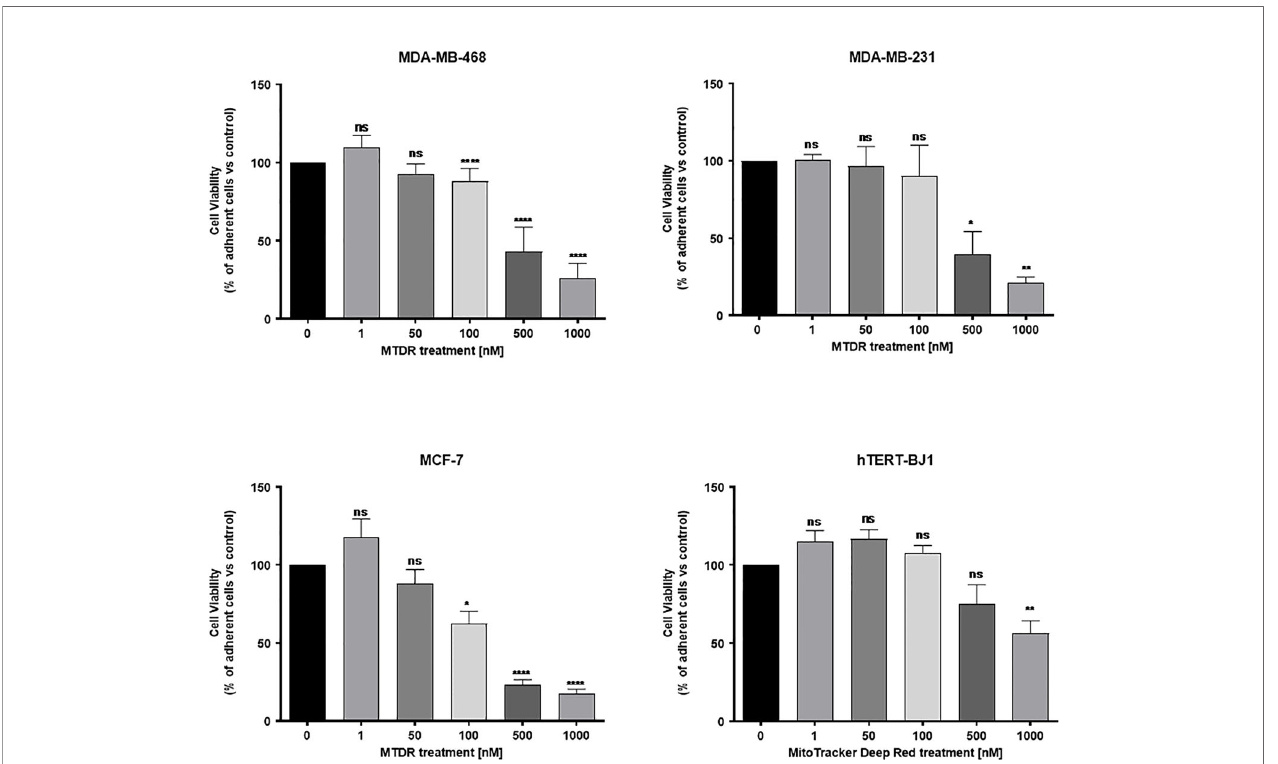
FIGURE 7 | MTDR preferentially and selectively targets cancer cells. MCF7, MDA-MB-231 and MDA-MB-468 cell monolayers were all treated with MTDR for a period of 72 hours and viability was assessed using Hoechst 33342, a nuclear dye that stains DNA in live cells. Effects of MTDR on the viability in normal human fi broblasts (hTERT-BJ1) were assessed in parallel. Note that MTDR effectively killed MCF7, MDA-MB-231 and MDA-MB-468 cells, but had little or no effect on normal cell viability (hTERT-BJ1), in the same concentration range. Therefore, MTDR was more potent and selective for the targeting of breast cancer cells, relative to normal fi broblasts. The statistical test used was a one-tail unpaired